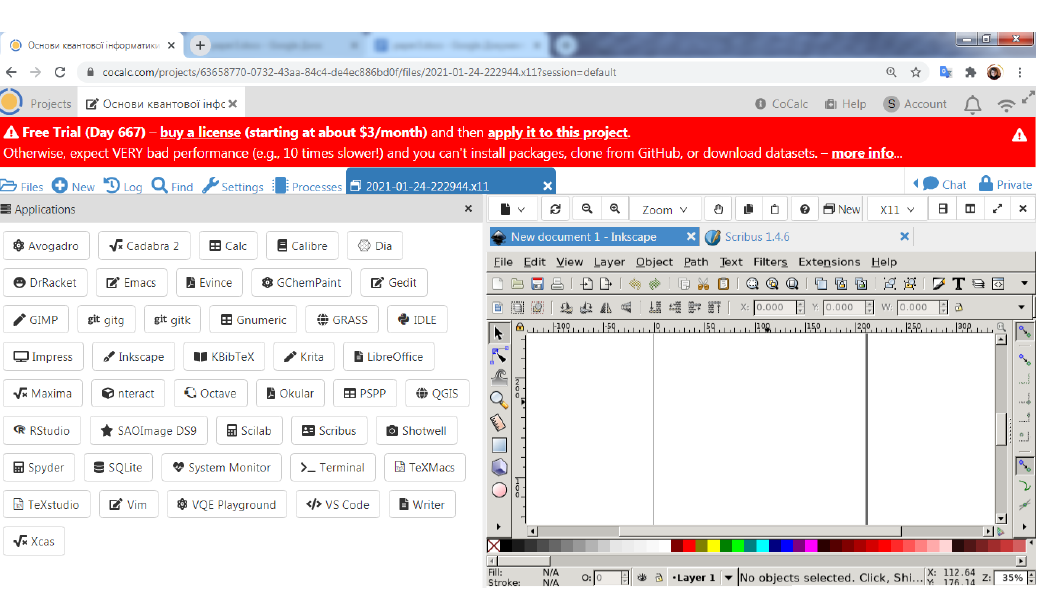
Figure 19: Presentation of paper [19].